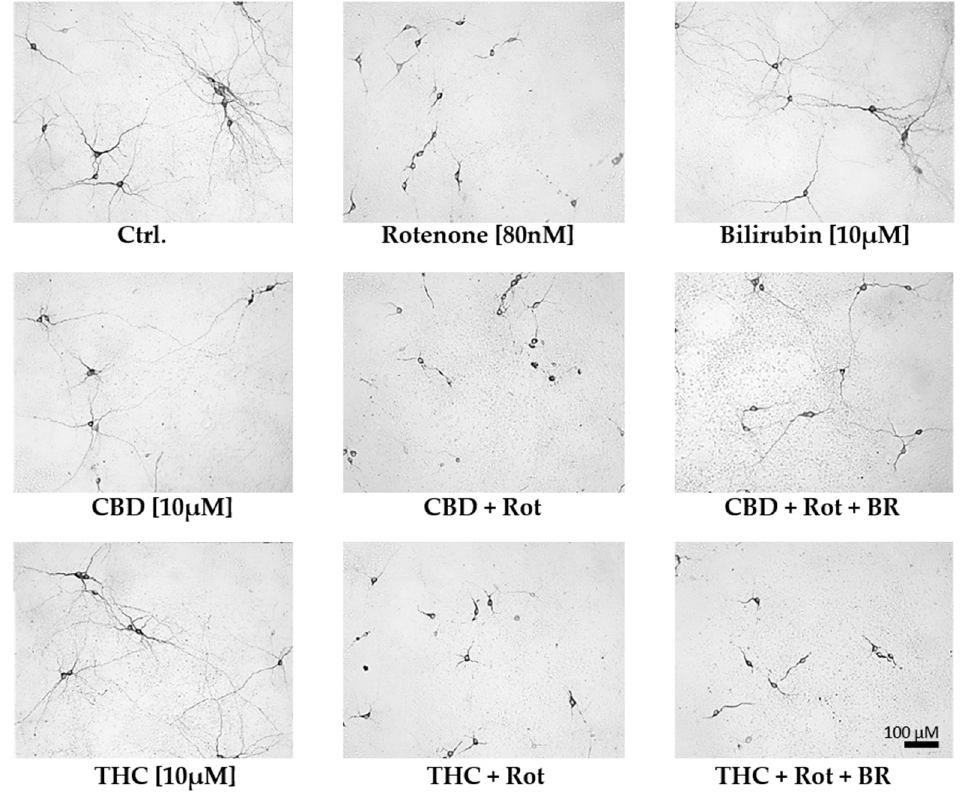
Figure 5. Cannabidiol and bilirubin in combination, partly prevent rotenone-induced morphological changes in neurons. Representative photographs were taken with 200 × magnification and illustrate the morphology of dopaminergic neurons in primary mesencephalic cell culture on the 12th day in-vitro. Compared to vehicle (DMSO) control cultures (Ctrl.), rotenone (Rot; 80 nM) treated cells exhibit degenerative cell bodies, shorter neurites, and a lower number of primary neurites. Mesencephalic cells treated with 10 µ M cannabidiol (CBD), tetrahydrocannabinol (THC), or bilirubin (BR) display a phenotype comparable to non-treated control (Ctrl.) neurons. Cells concomitantly treated with CBD, Rot, and BR have longer neurites than cells treated with CBD and Rot, but the number of primary neurites is still lower than in controls. Note that the number of dopaminergic neurons in the photographs does not fully reflect the overall number of cells in the entire culture dish.